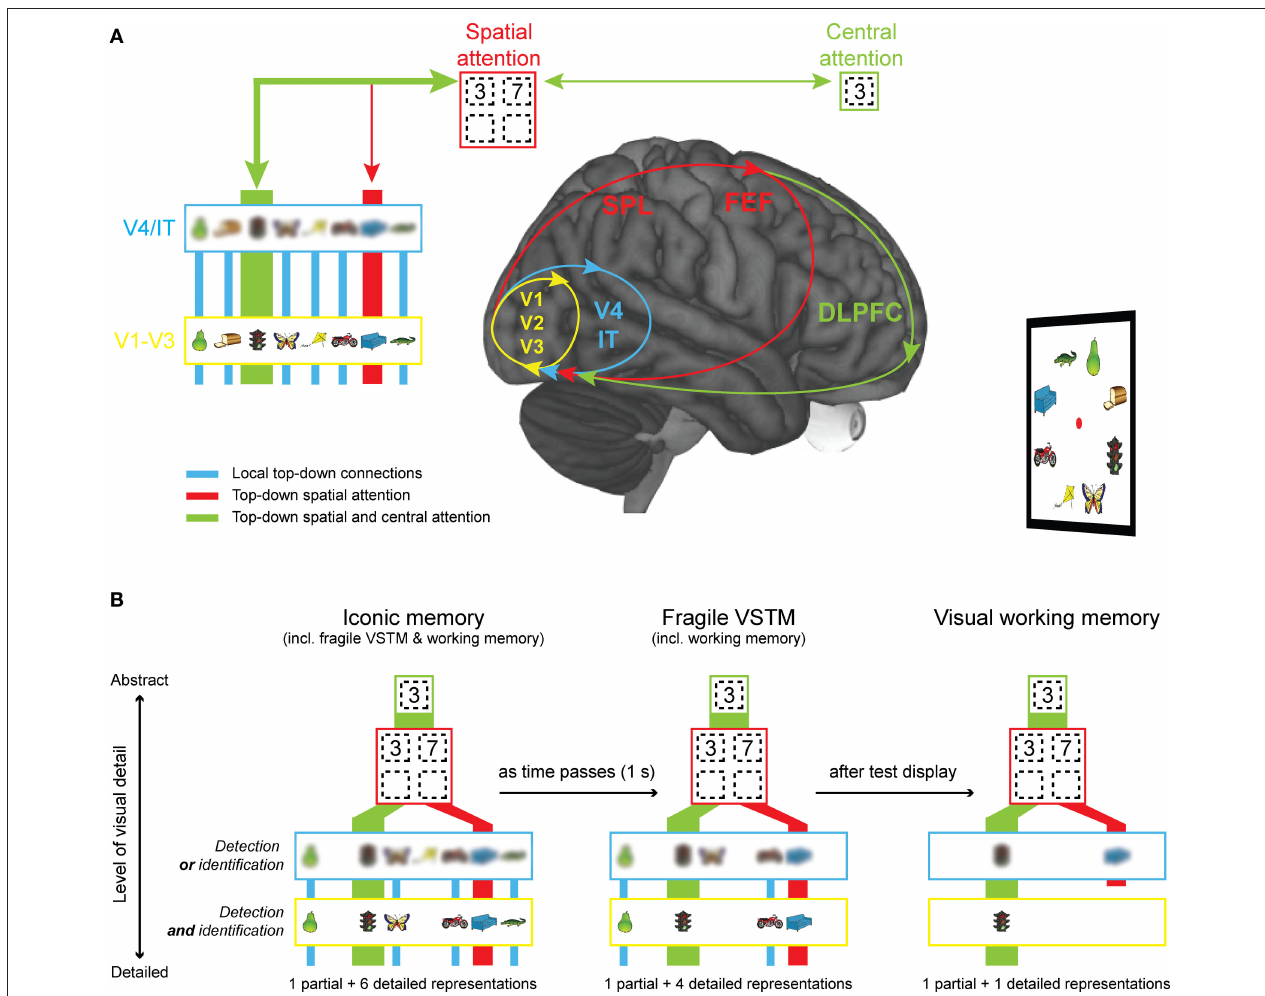
Figure 4 | explaining VSTM resolution from a neural perspective. (A) During image perception, high-resolution representations are formed in primary, visual cortex (V1–V3; in yellow). In higher visual areas (V4/IT; in blue), the receptive field size of neurons becomes larger and as a consequence, the resolution of representations becomes more limited (shown as a blur). Spatial attention (in red), subserved by the superior parietal lobe (SPL) and the frontal eye fields (FEF), imposes even stricter capacity limits on the amount of information that can be represented (shown as four location slots). Finally, central attention (in green), speculatively subserved by the dorsolateral prefrontal cortex (DLPFC), can only be directed to one item at a time. A major assumption of the model is that all forms of visual short-term memory depend on recurrent processing. (B) Representations at the lowest level in the visual hierarchy are high-resolution or visually detailed representations that support